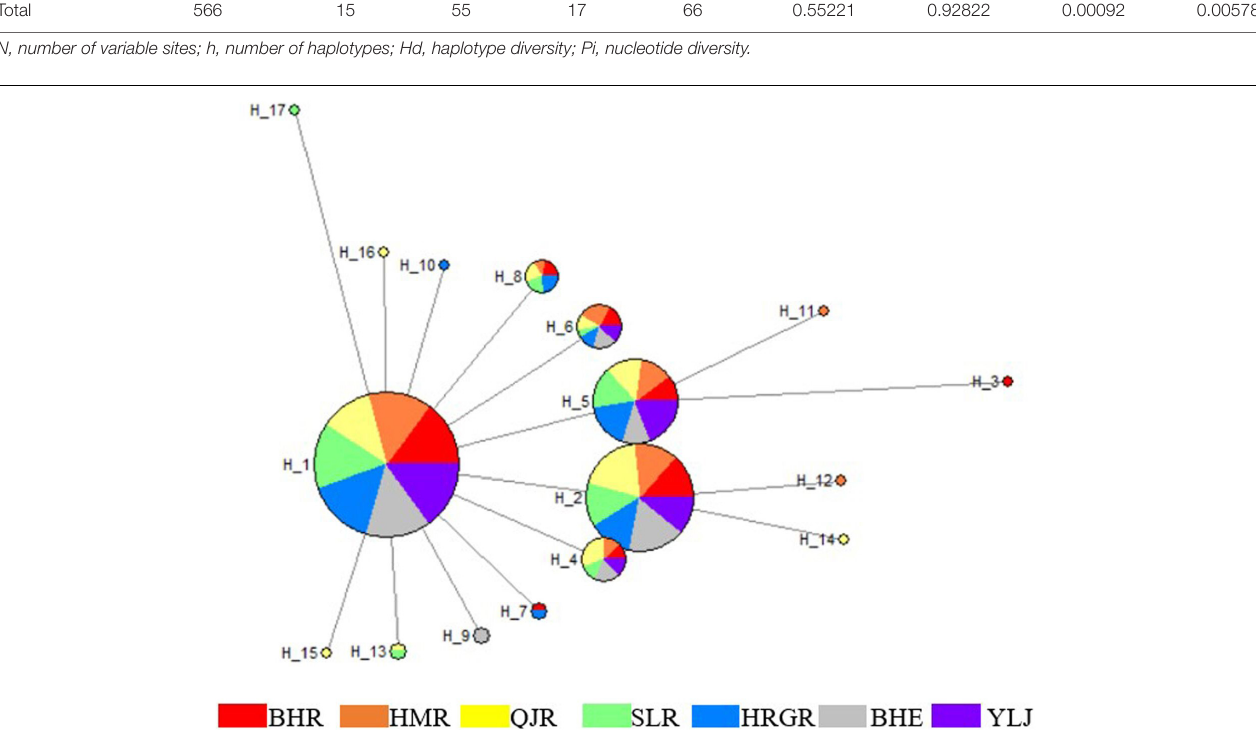
distances between Hap 31 and Hap 61, Hap 28 and Hap 62, and Hap 20 and Hap 63 were 0. The genetic distances between Hap 57 and Hap 53 as well as Hap 57 and Hap 13 were both the maximum value of 0.02831. Hap 57 and Hap 53 were exclusive to the YLJ population, while Hap 13 was shared by the HeGR, SLR, and QJR